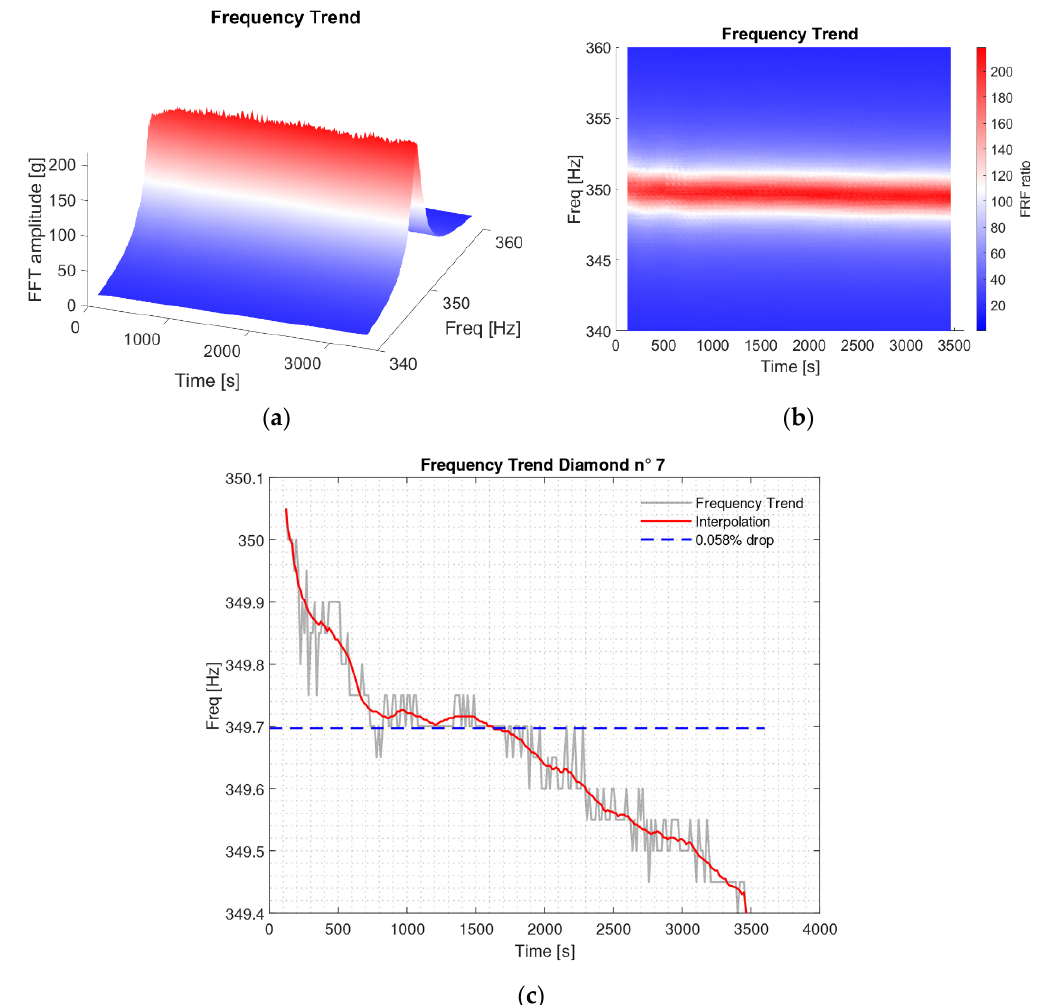
Figure 7. Spectrogram relative to the FCC specimen number 4 tested under random vibration. ( a ) Axonometric and ( b ) top view. The frequency trend is tracked and displayed in ( c ) for a better visualization of the failure time.